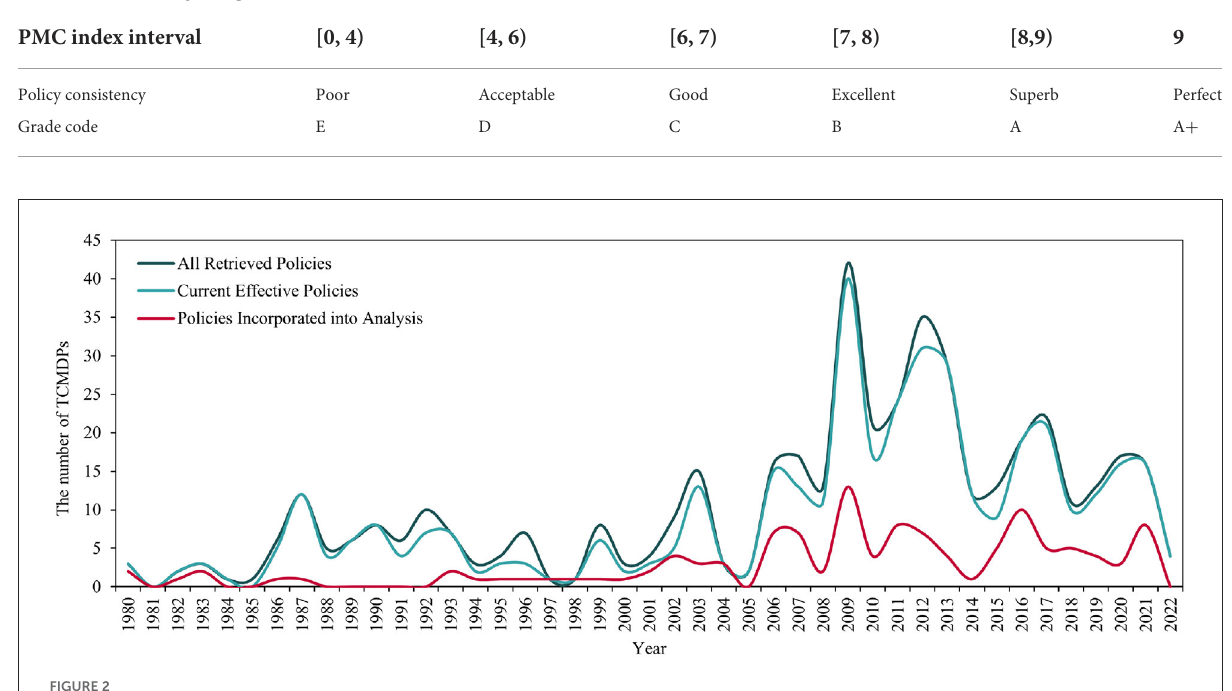
FIGURE2 Inter-annual variation curve of the number of TCMDPs issued.